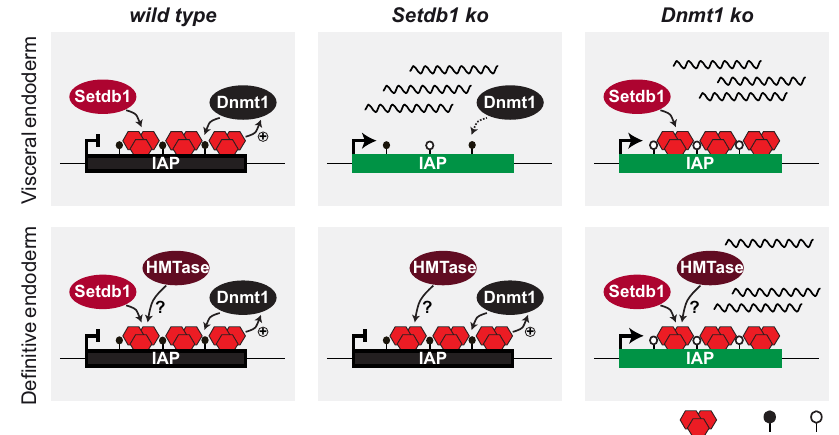
Fig. 6 | Model. Schematic depicts a dominant role of DNA methylation over H3K9me3 for ERV silencing in endodermdifferentiation. Depletion ofSetdb1 leads to augmented H3K9me3 and DNA methylation and impaired ERV silencing in visceral endoderm but not in de fi nitive endoderm cells. In contrast, depletion of